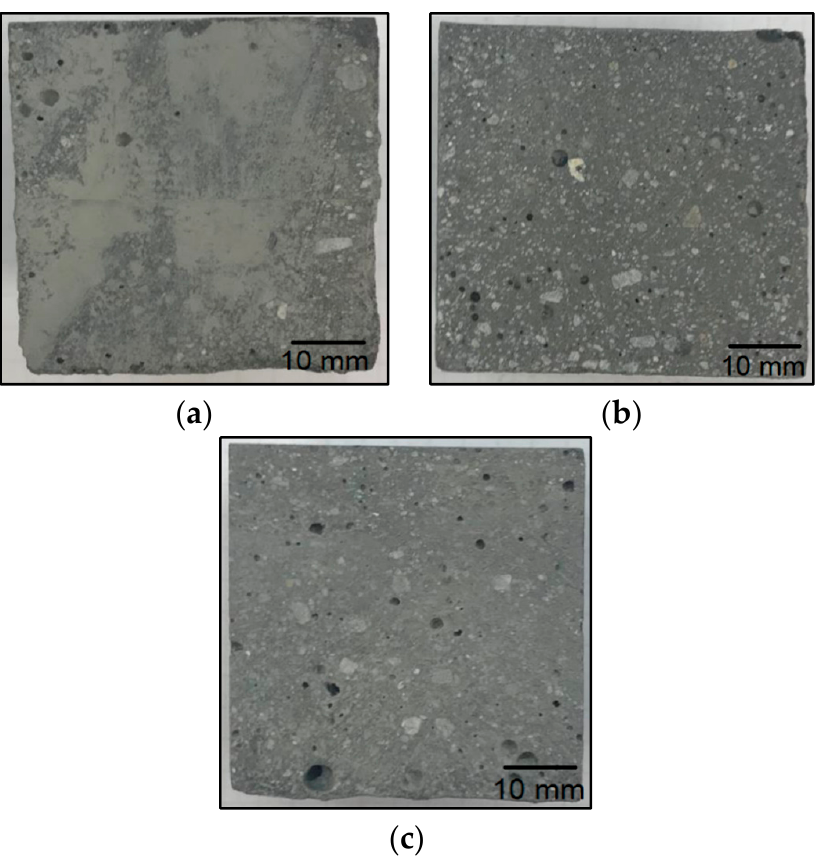
Figure 14. Breakthroughs of geopolymer samples based on fly ash and river sand with the addition of fraction III from a windmill turbine: ( a ) 5% fraction addition; ( b ) 15% fraction addition; ( c ) 30% fraction addition.